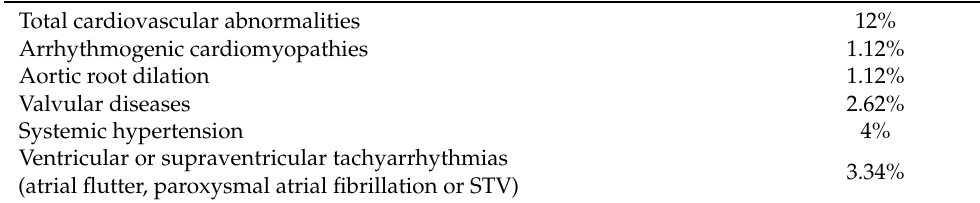
Table 1. Prevalence of cardiovascular abnormalities in Paralympic athletes. Total cardiovascular abnormalities 12% Arrhythmogenic